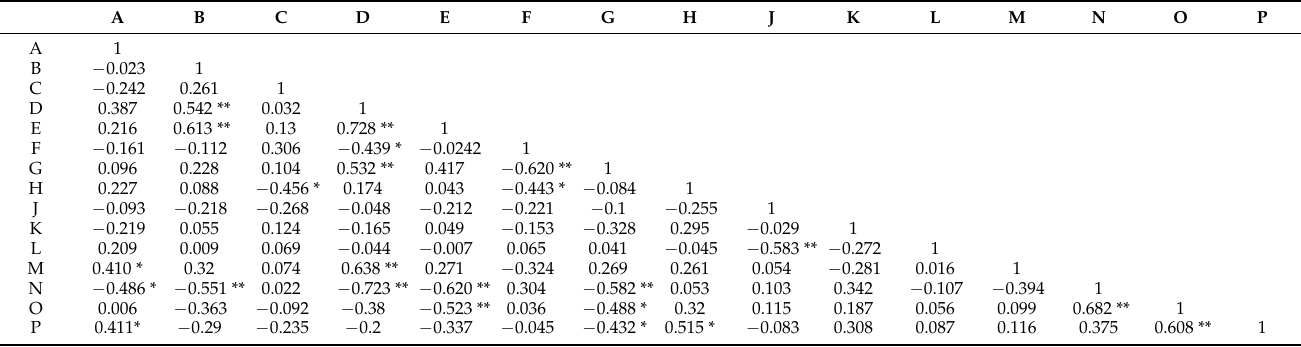
* Significant correlation at 0.05 level (bilateral), ** significant correlation at 0.01 level (bilateral). A: invertase; B: urease; C: phosphatase; D: polyphenol oxidase; E: atrazine residue; F: saccharides; G: carboxylic acids; H: amino acids; J: polymers; K: phenolics; L: amines; M: AWCD; N: Shannon; O: Simpson; P: McIntosh. Each value represents mean ± SD (n =